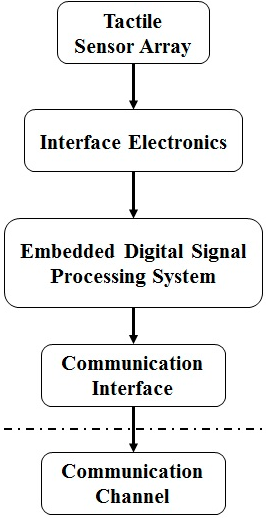
Figure 1. Structural block diagram of an e-skin system.